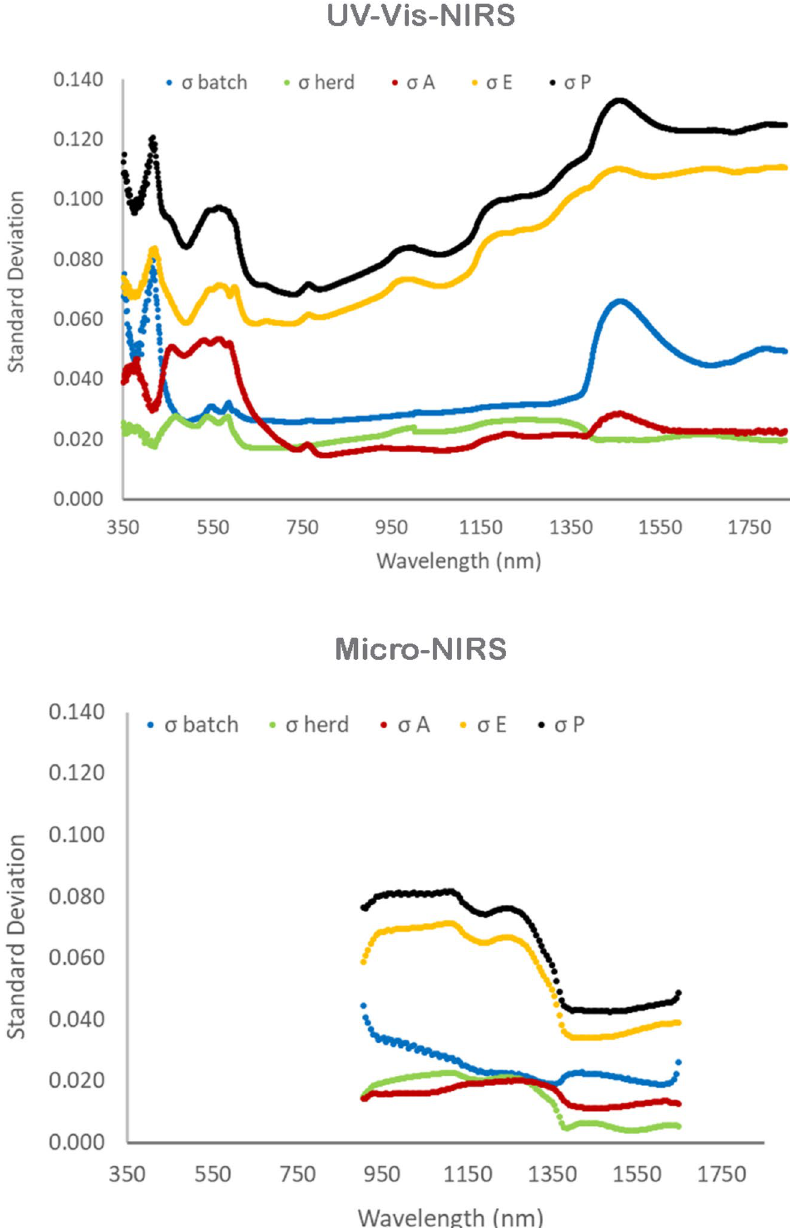
Figure 3. Standard deviations of the different sources of variation in absorbance. Phenotypic (σ P , black color), batch (σ batch , blue color), herd (σ herd , green color), additive genetic (σ A , red color), and residual (σ E , yellow color) standard deviations of absorbance of each individual wavelength of the